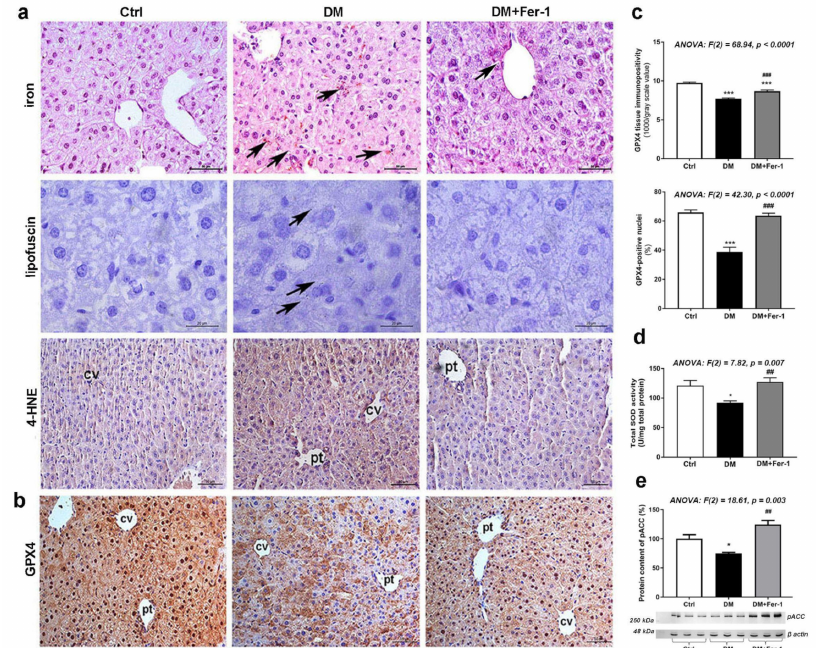
Figure 2. Lipid peroxidation-related and antioxidative parameters in liver tissue in control (Ctrl), dia- betic (DM), and diabetic Fer-1-treated (DM + Fer-1) animals. ( a ) DAB-enhanced Pearls’ iron staining demonstration of ferrous ions accumulation (arrows); Sudan III stain-detected lipofuscin (arrows) and immunohistochemical detection of 4-HNE; scale bars: iron and 4-HNE—50 µ m, lipofuscin—20 µ m. ( b ) Immunohistochemical detection of GPX4; scale bars: 50 µ m and ( c ) quantification of tissue and nuclear GPX4 immunopositivity; cv—centrilobular vein, pv—portal vein. ( d ) Total SOD activity. ( e ) Protein content of pACC; β -actin serves as a protein-loading control; blots represent three inde- pendent experiments. Values presented as means ± SEM. Statistical significance: compared with the Ctrl group (*), * p < 0.05, *** p < 0.001; DM vs. DM + Fer-1 comparison (#), ## p < 0.01; ### p <